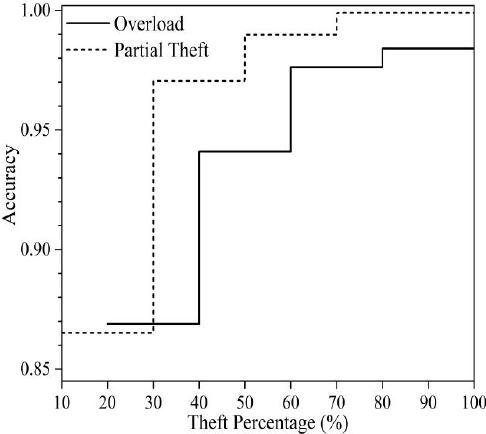
Figure 8. Accuracy metric for partial power theft and overload scenarios.